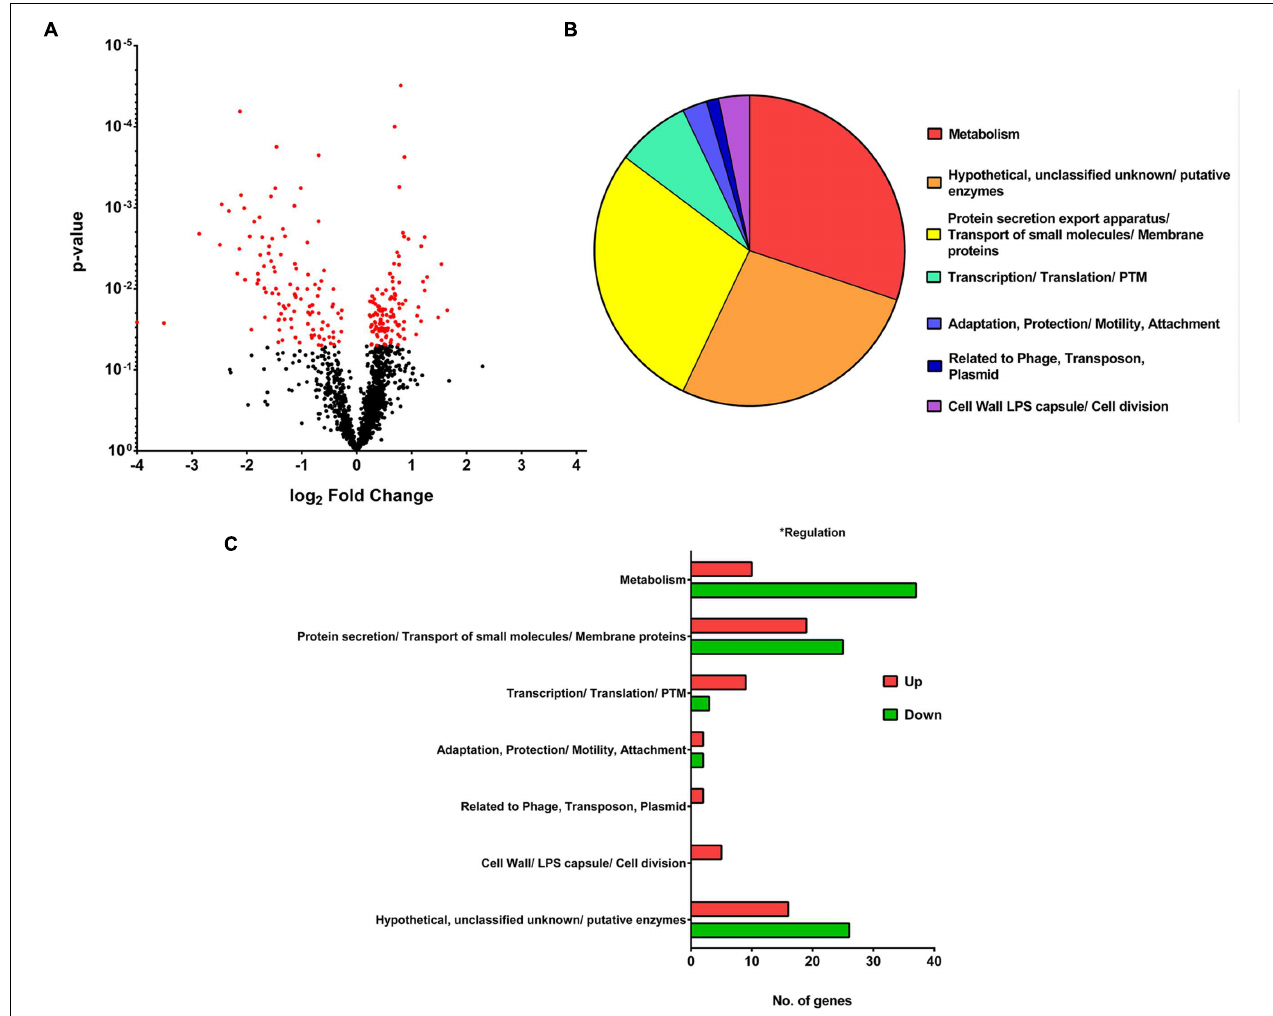
FIGURE 3 | Microarray analysis. (A) Volcano Plot showing the fold change and p -value of the 1566 probesets. For a gene to be differentially expressed, it must satisfy the criteria of p -value < 0.05 and fold change > 1.5 or < − 1.5. One hundred and forty-eight differentially expressed genes (DEGs) are shown in red on the plot. (B) Pie chart showing PseudoCAP functional classification of DEGs, with metabolism, hypothetical proteins and protein secretion forming the majority. (C) Bar graph showing PseudoCAP functional classification of DEGs sorted according to their expression level.